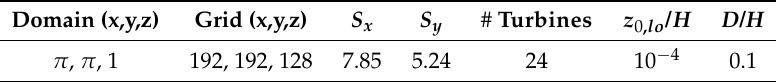
Table 1. Parameters common to wind farm large eddy simulation (LES) cases. S x is the streamwise distance between turbine rows, normalized by the turbine diameter. S y is the spanwise distance between turbine columns, normalized by the turbine diameter. D is the turbine diameter, H is the height of the domain, and z 0, lo is the roughness height of the lower wall. Domain (x,y,z) Grid (x,y,z) S x S y # Turbines z 0 , lo / H D / H π , π , 1 192, 192, 128